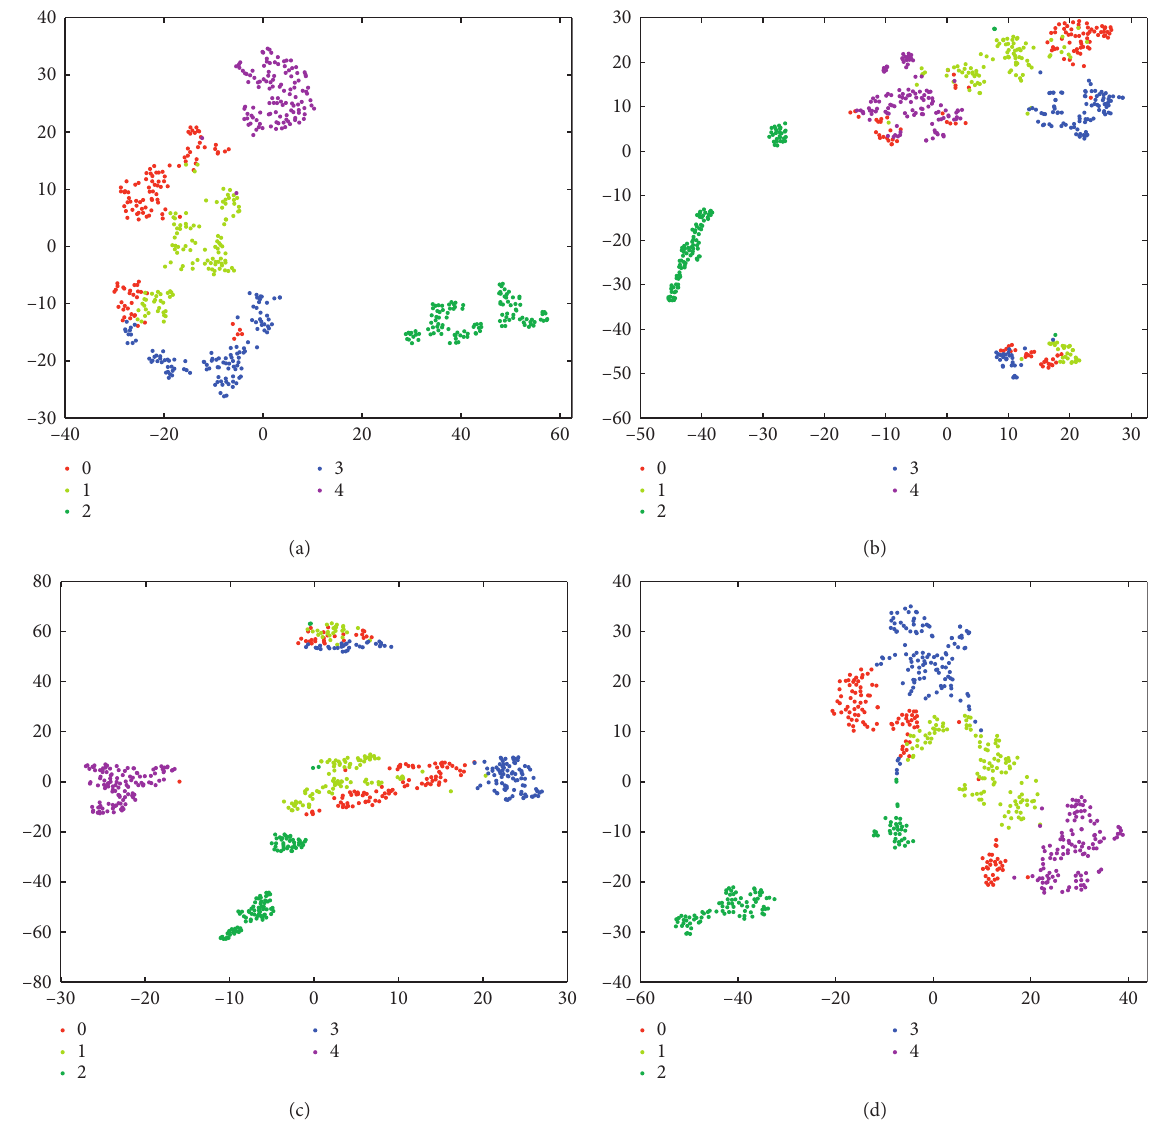
Figure 8: The t-SNE figure of feature extracted by CNN-S: (a) condition 1, (b) condition 2, (c) condition 3, (d) condition